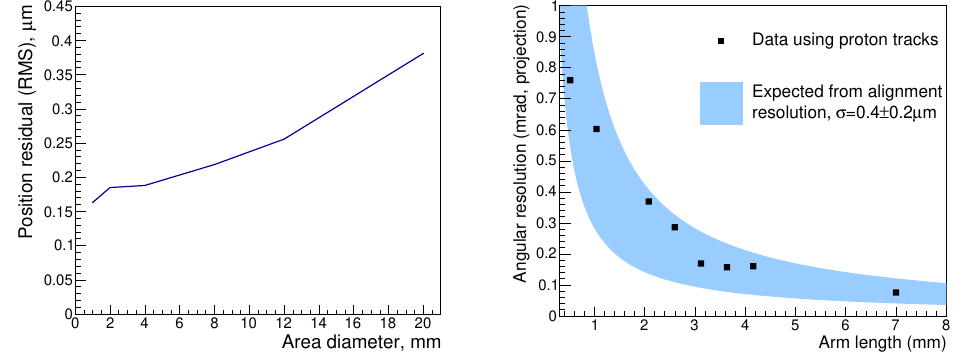
Figure 14 . Left: alignment resolution obtained in data as a function of the diameter of data processing unit. Position displacement of basetracks from the reconstructed track (a straight line) is evaluated. Right: angular resolution of tracks obtained by the HTS as a function of reconstructed track length. The X-axis is the length used for the angular